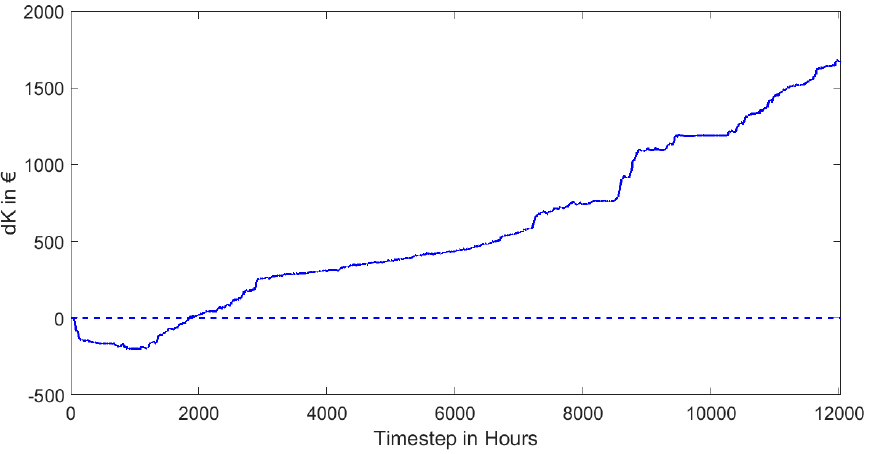
Figure 16. Difference of cumulated operation cost to the reference simulation with standard Figure 16. Di ff erence of cumulated operation cost to the reference simulation with standard controller controller for scenario #2. for scenario #2.